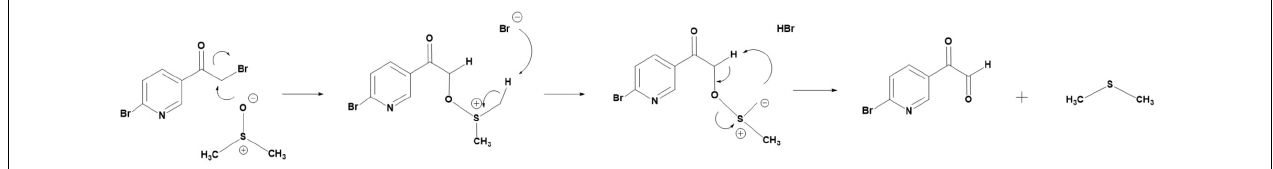
FIGURE 6 | The proposed reaction mechanism of the formation of a glyoxal and dimethyl sulfide from an α -bromoketone and DMSO (Kornblum et al., 1957; Imperial College London,